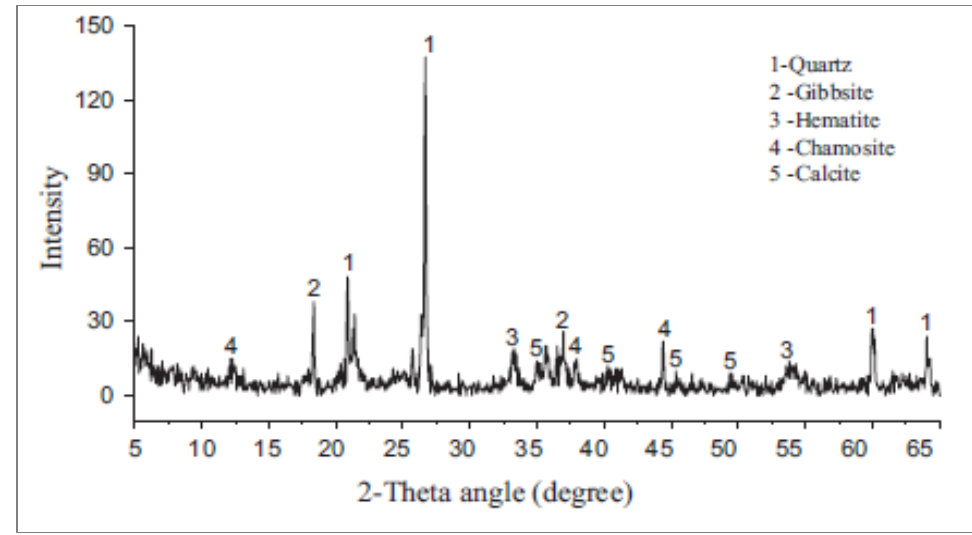
Figure 4. XRD analysis of iron ore (used with permission, Elsevier [48]).